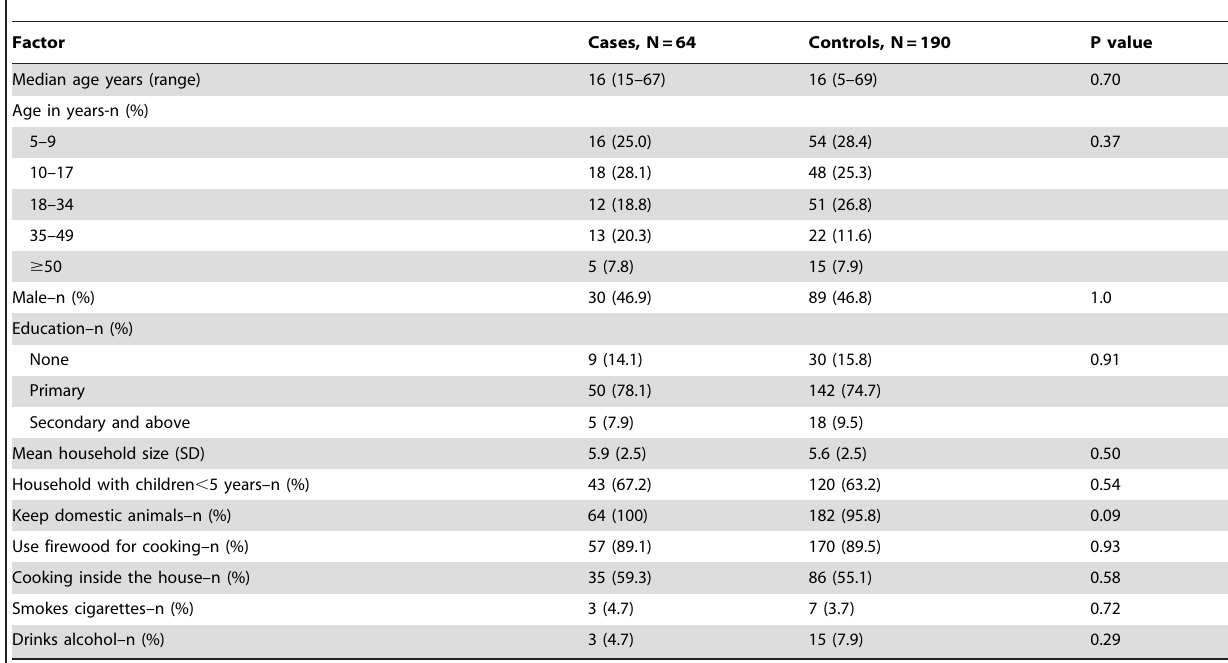
Table 1. Description of the study participants in case-control study of risk factors for hospitalized influenza, Bondo District, Kenya,